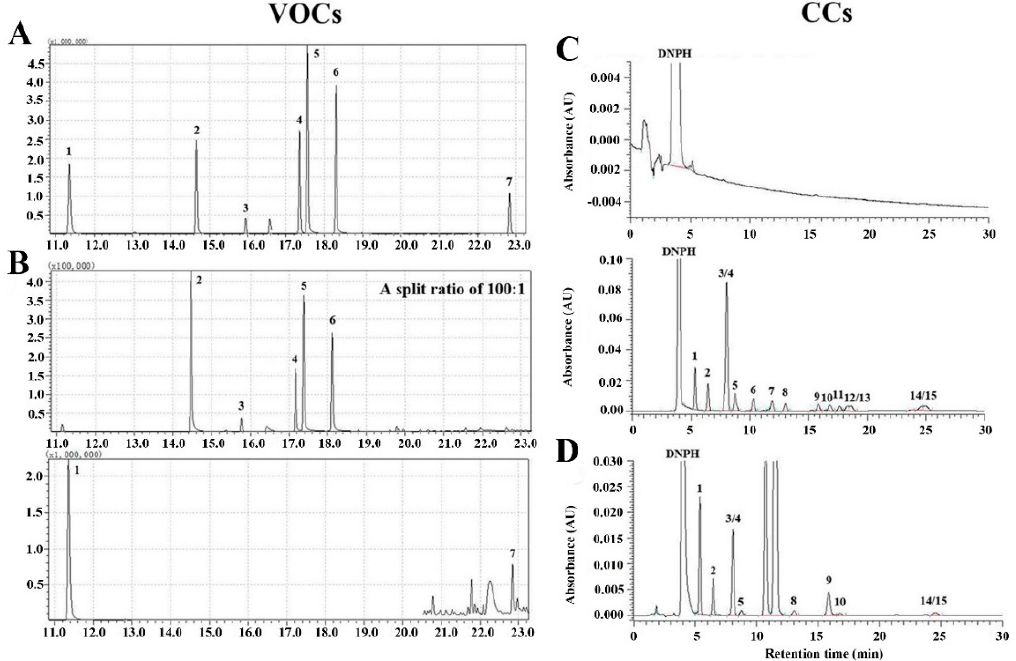
Figure 1. Representative chromatogram for the VOCs and CCs detected in the air-conditioned coaches. ( A ) Chromatogram for the VOCs standards spiked into Tenax TA tubes; ( B ) Typical chromatogram of VOCs in the air samples collected in the medium-size coaches. Two-stage desorption analysis mode was used. Peaks in ( A , B ) 1. Benzene, 2. Toluene, 3. n -Butyl Acetate, 4. Ethylbenzene, 5. Xylene, 6. Styrene, 7. n -Undecane; ( C ) HPLC chromatogram for the DNPH-derivatized CCs standards;